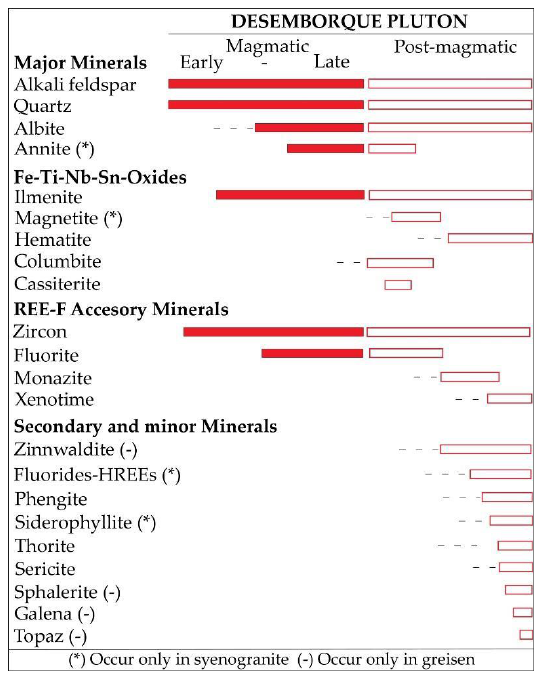
Figure 4. Interpreted crystallization sequence for the studied rocks from the Desemborque Pluton, showing the mineral occurrence at early-, late-, and post-magmatic stages.